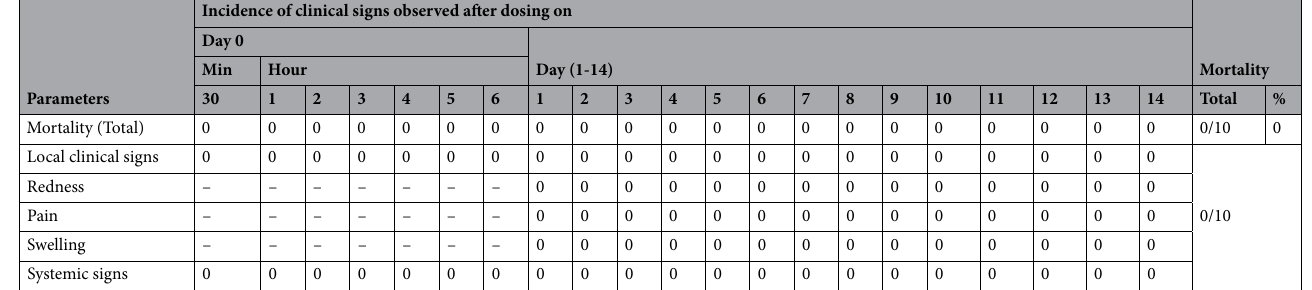
Table 7. Recorded clinical signs and mortality for range-finding study and confirmatory test due to applied GbH. − = Observed after 24 h; 0 = No clinical signs; + = Mild; + + = Moderate; + + + = High and + + + + =